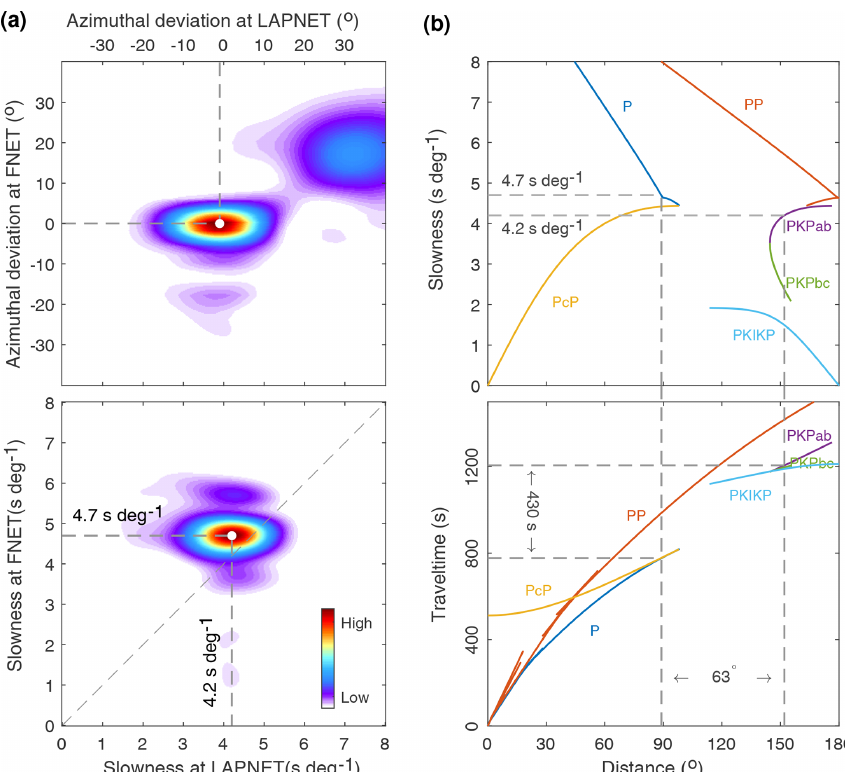
Figure 5. (a) Results of the double-array slowness analysis for the observed spurious phase. (b) Tracking the interfering waves responsible for the spurious phase using the slowness